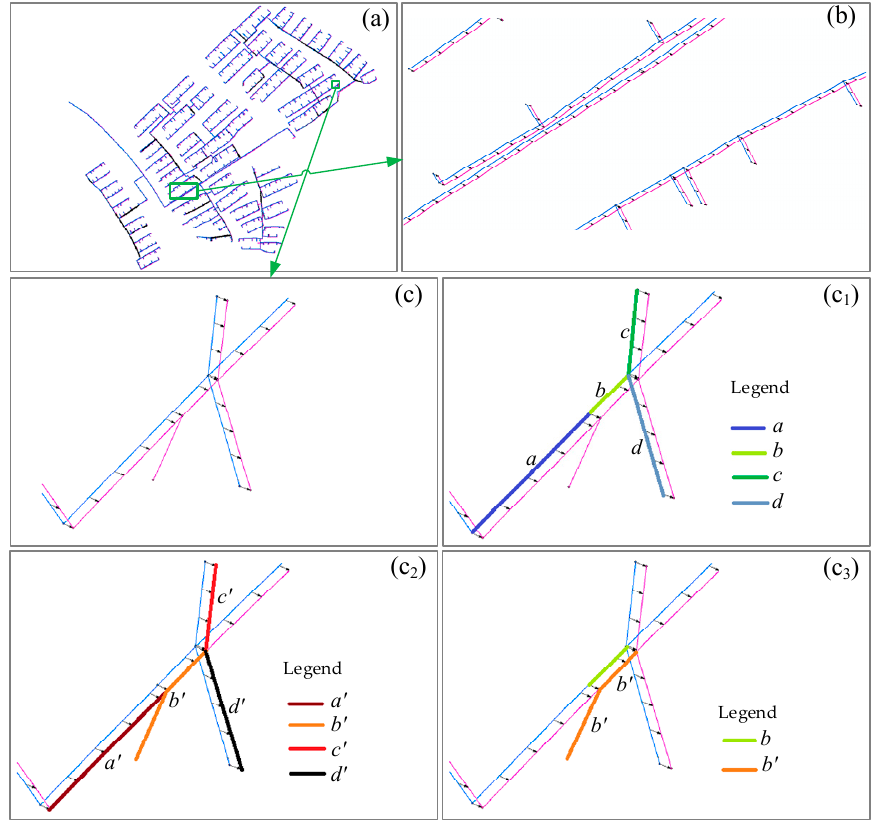
Figure 17. Matching results of the integrated and professional pipelines. The lines with arrowheads represent matching relationship, the blue lines are integrated pipelines, and the pink lines are professional pipelines; ( a ) Shows all the matching results; ( b ) shows the matching result of parallel double line; ( c ), ( c 1 ), ( c 2 ), and ( c 3 ) explain the matching process.